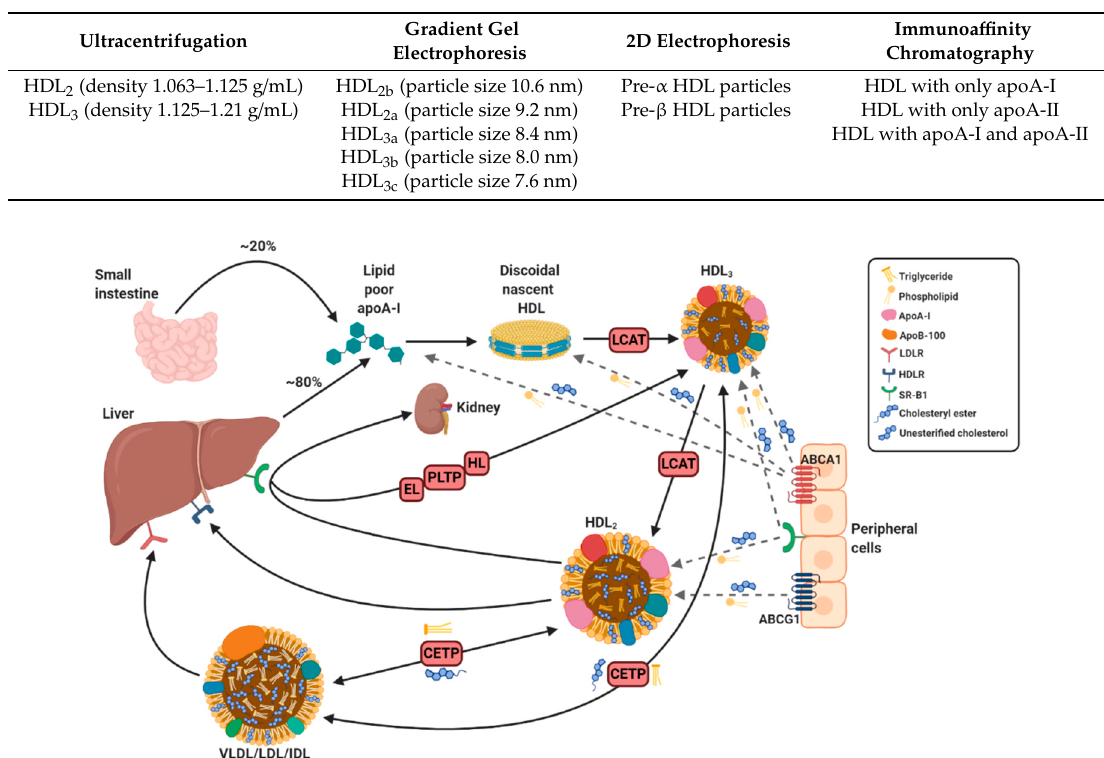
Table 1. Major high-density lipoprotein (HDL) subclasses according to di ff erent separation techniques.